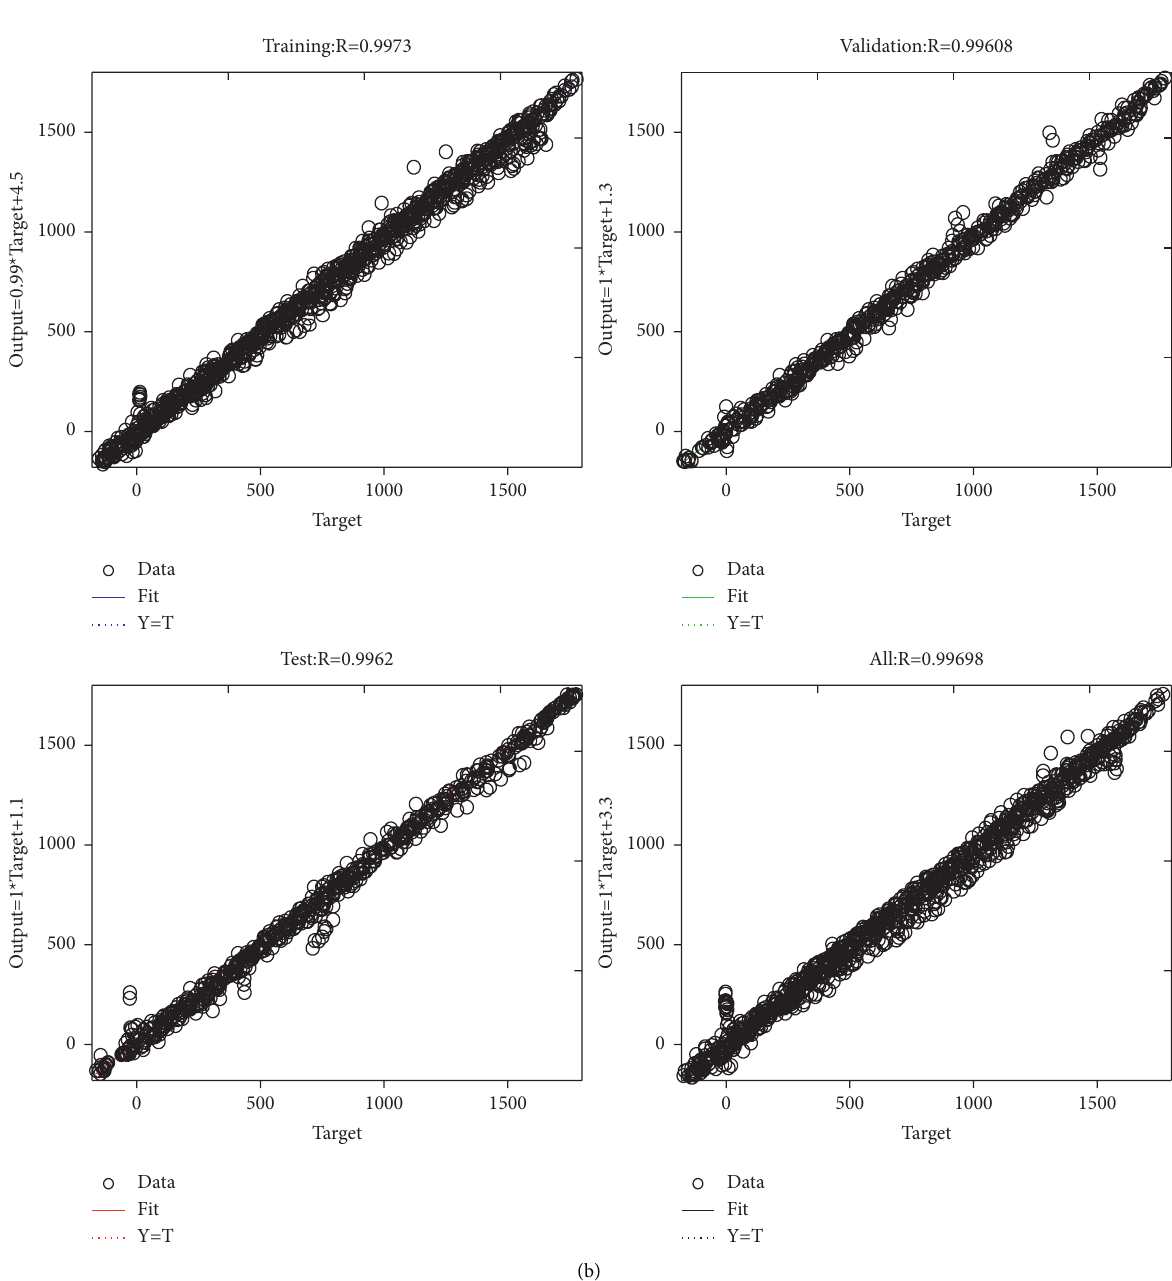
Figure 14: Scatter plot of models and determination coefficient. (a) BPNN; (b)